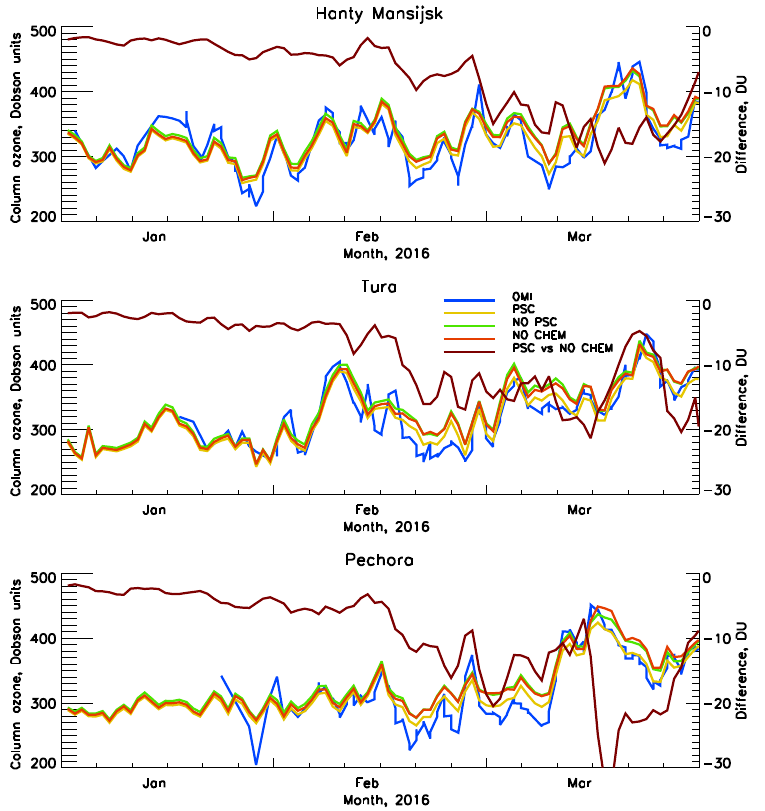
Figure 6. Column ozone variability simulated with the RSHU CTM for different scenarios for the stations Khanty-Mansiysk, Tura, and Pechora and the difference between scenarios with no polar chemistry and full PSC processing